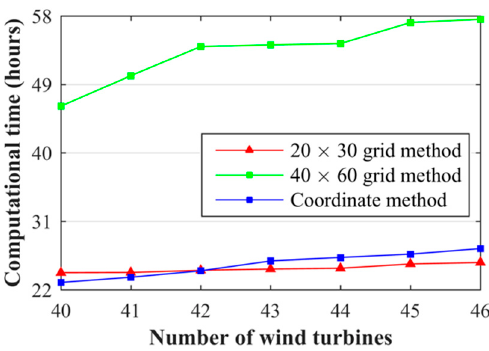
Figure 7. Computational time of different design methods for different wind turbine numbers.